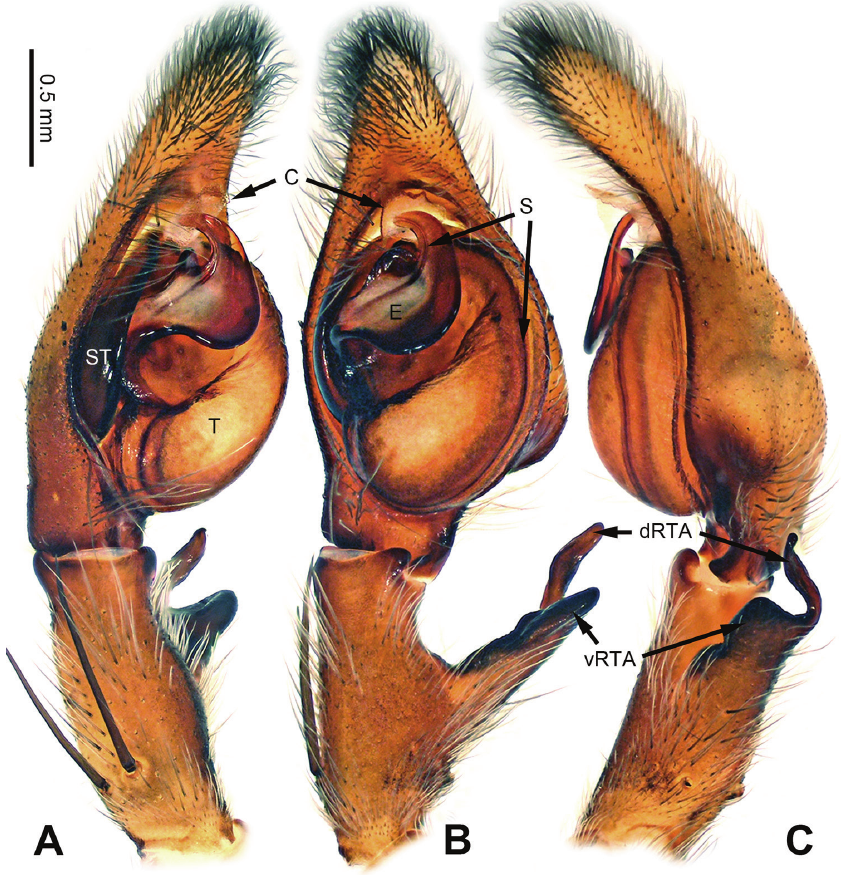
Figure 16. Pseudopoda nyingchiensis Zhao & Li, sp. n., right palp of male holotype, horizontally flipped for the sake of comparison. A Prolateral view B Ventral view C Retrolateral view. Scale bar equal for A , B, C .